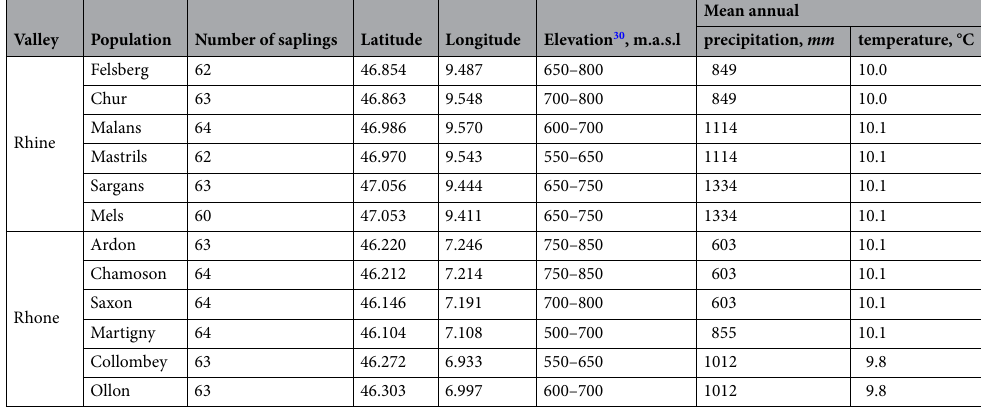
Valley Population Number of saplings Latitude Longitude Elevation 30 ,